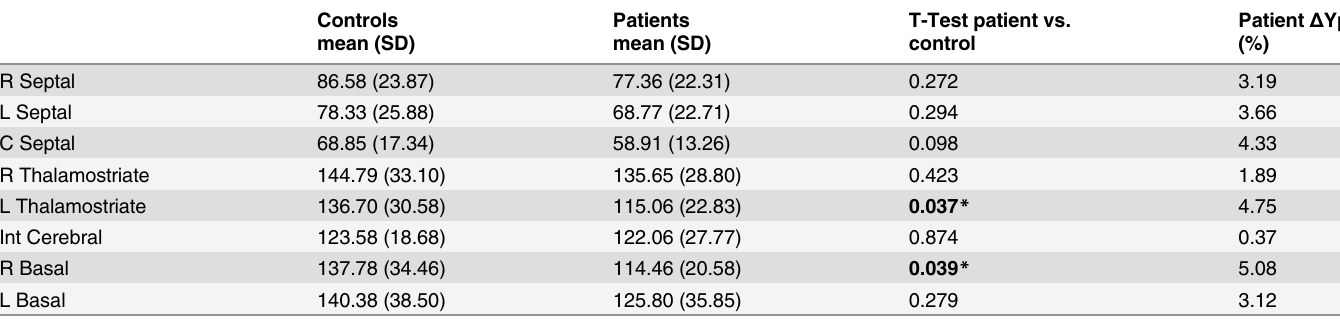
Table 2. Group mean values for each vein and student ’ s T-test comparison between control and patient groups.